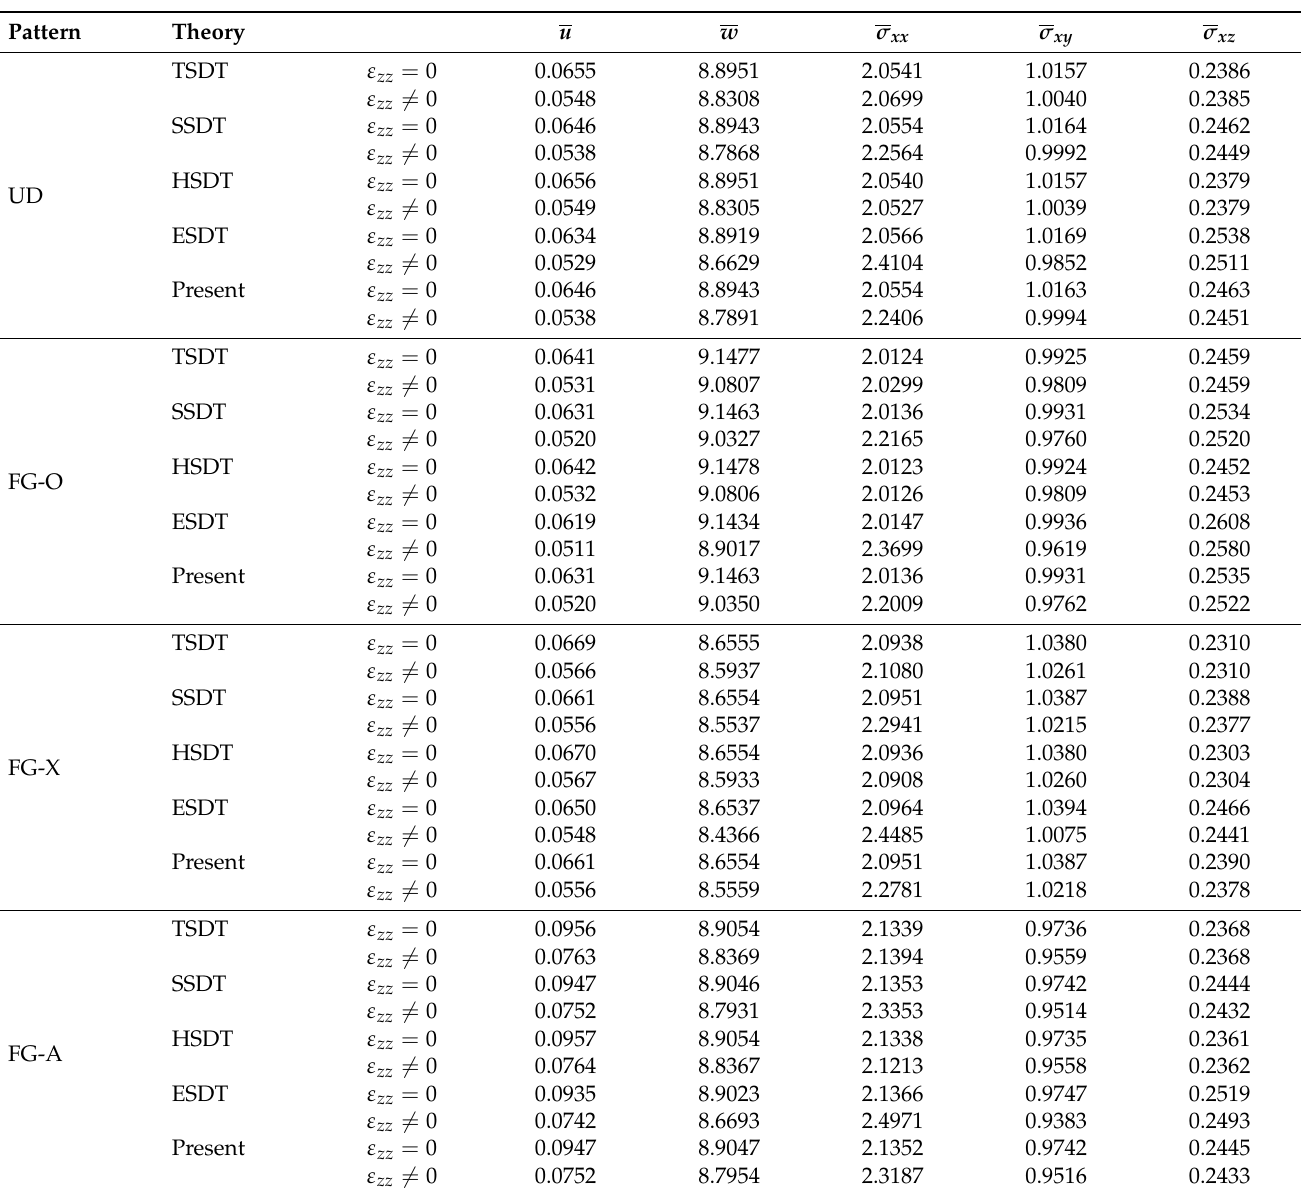
Table 9. Dimensionless displacements and stresses of simply supported square GRC plate for